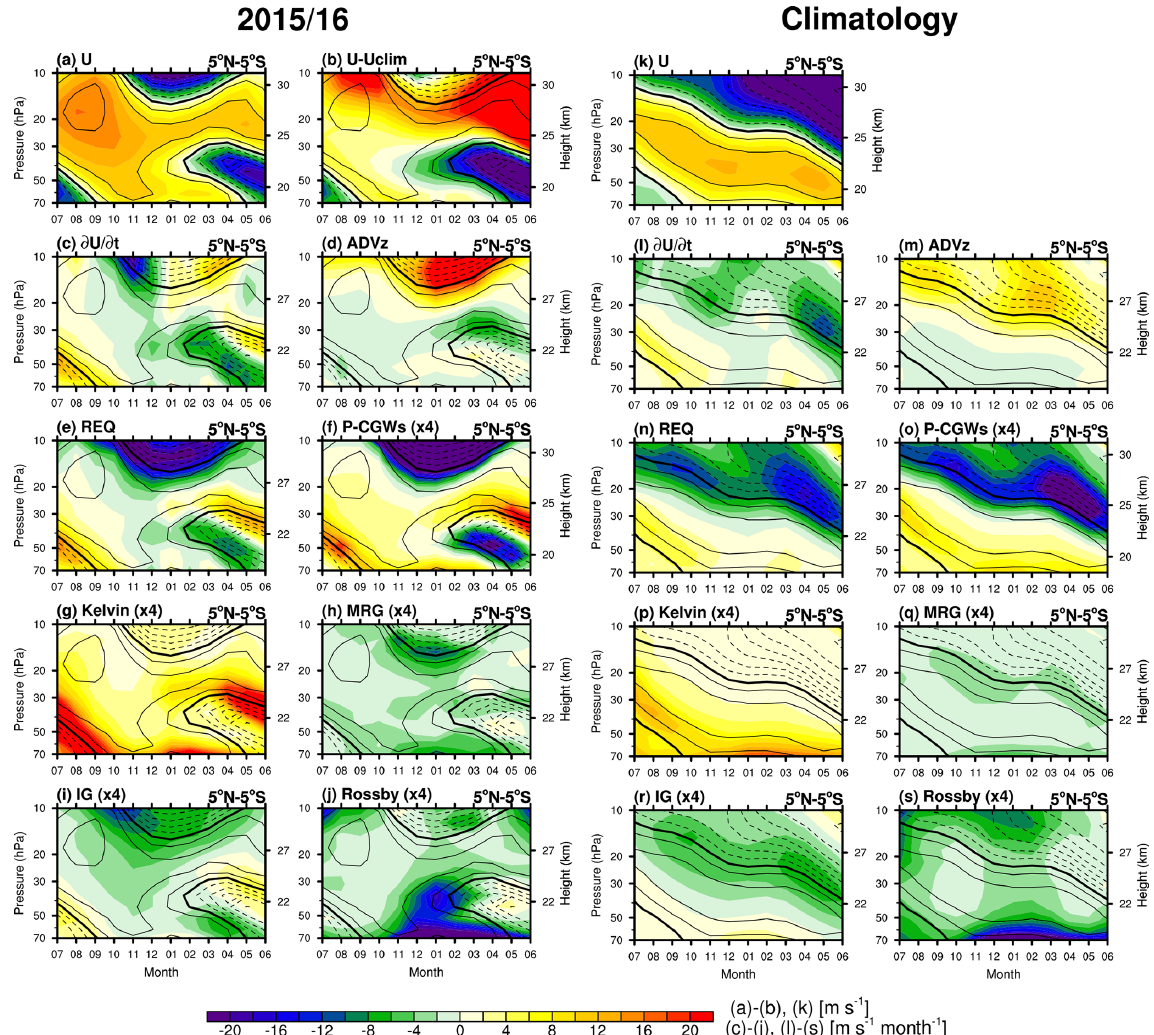
Figure 3. Time–height cross sections of the (a) zonal-mean zonal wind ( U ), (b) zonal wind anomaly from the climatology (U-Uclim), (c) zonal wind tendency ( ∂U/∂t ), (d) vertical advection (ADVz), (e) required wave forcing (REQ) in the TEM equation, and EPD for the (f) P-CGWs, (g) Kelvin, (h) MRG, (i) IG, and (j) Rossby waves (left) from July 2015 to June 2016 and (k–s) their climatology from July to June, overlaid with the zonal-mean zonal wind (black contour lines). Positive (negative) zonal winds are plotted with solid (dashed) lines with a contour interval of 5ms − 1 , and thick contour lines denote a zero zonal wind